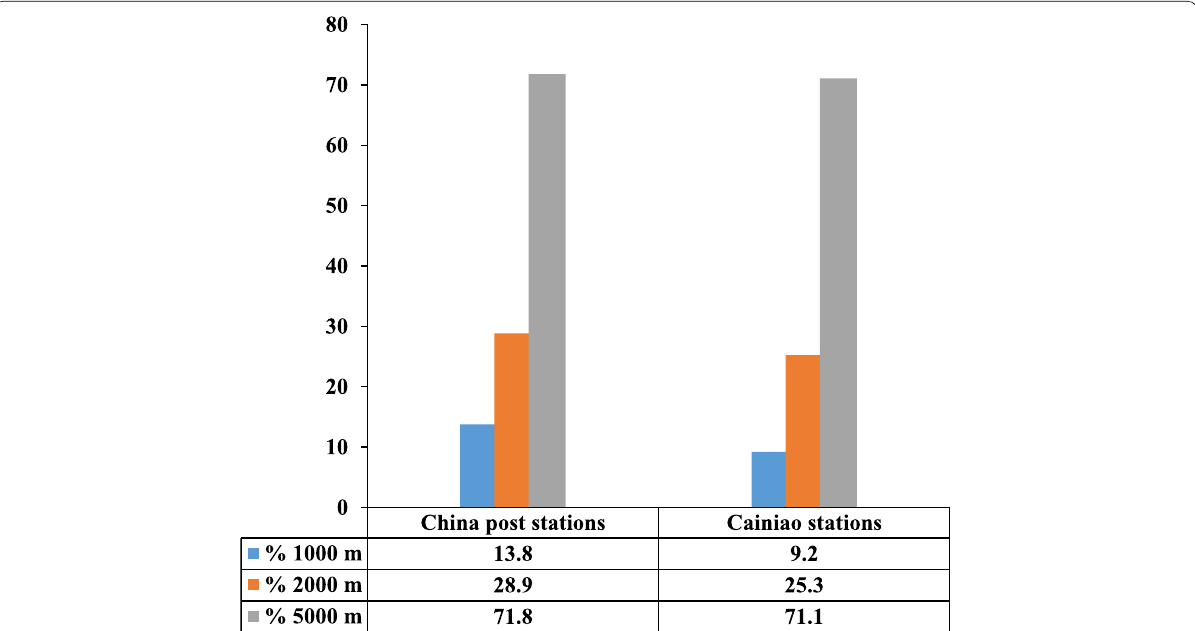
Fig. 6 Frequency graph of various accessibility modes according to service coverage